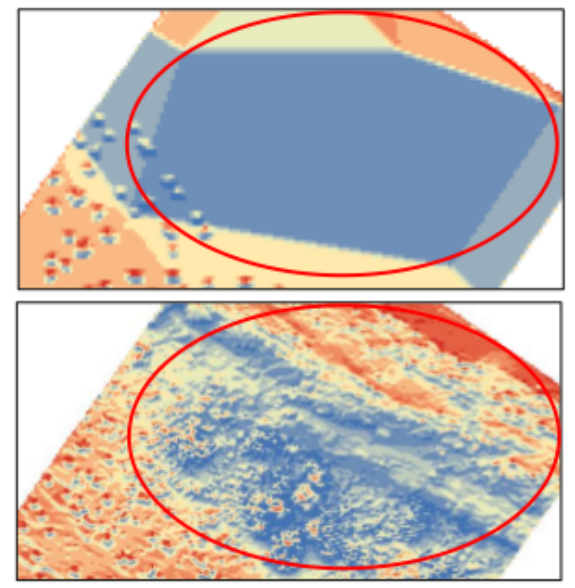
Figure 8. Data quality loss due to TIN conversion when preparing the 2m DSM (top); Quality unaffected with the 1m DSM